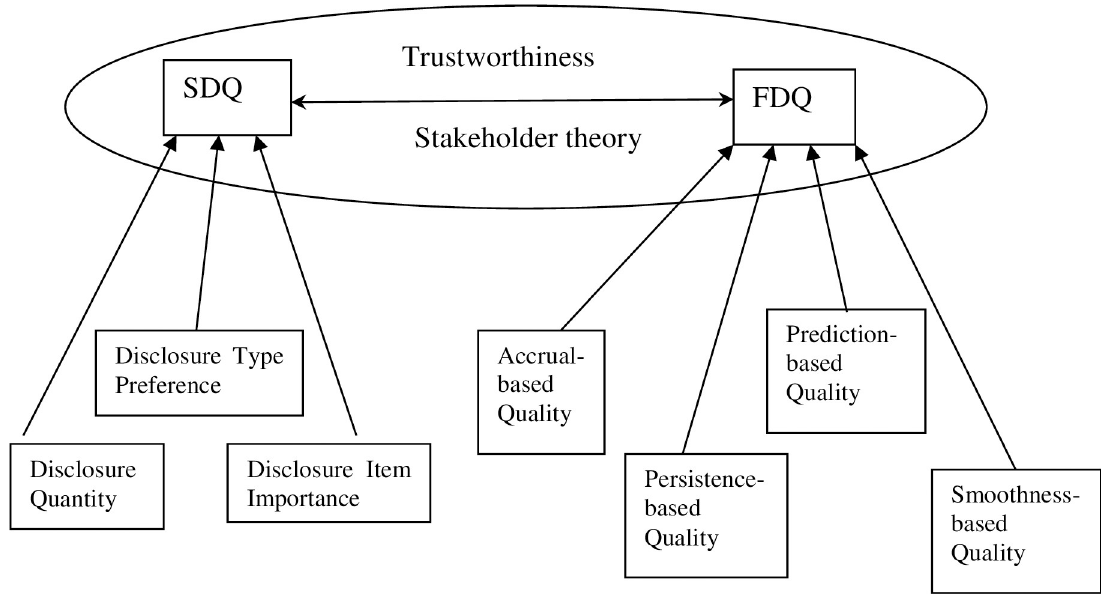
Fig 1. Theoretical